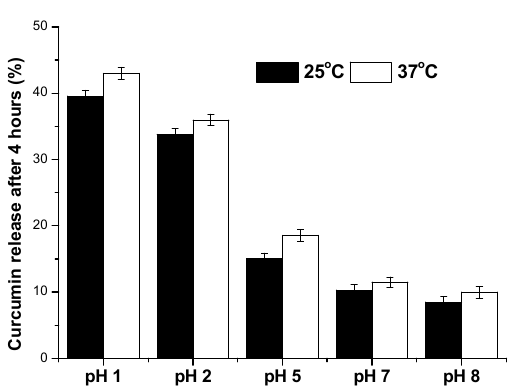
ff erent bu ff er solutions at 25 and 37 ◦